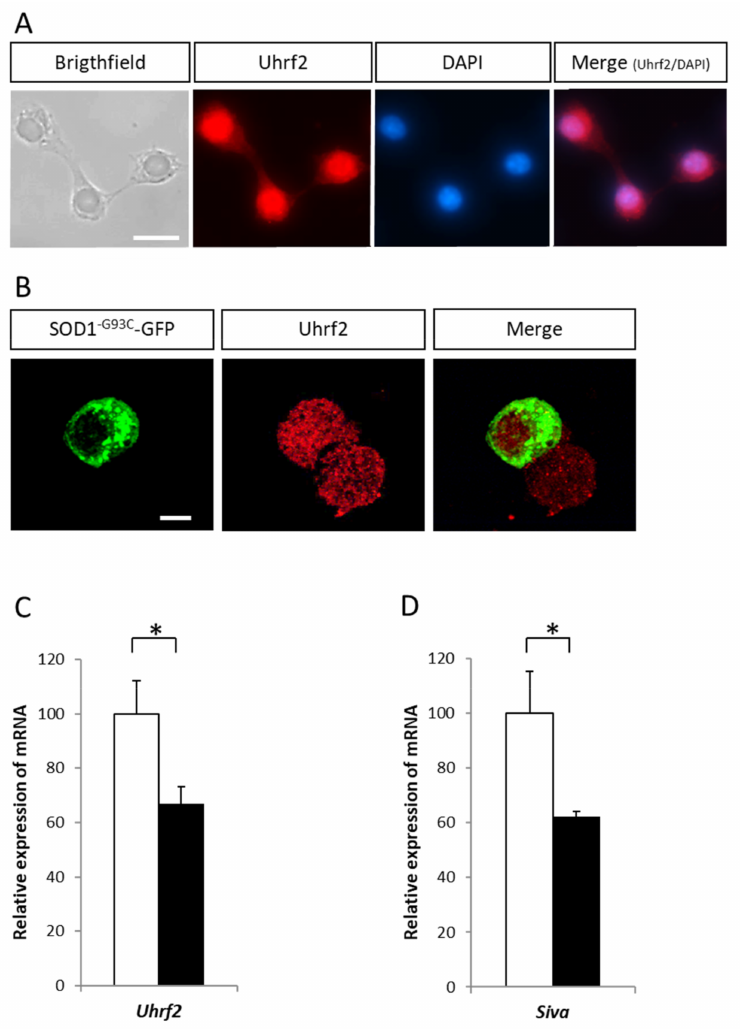
Figure 3. ( A ) Immunocytochemical visualization of Uhrf2 in NSC34 cells. ( B ) Absence of colo- calization of SOD1 G93C -GFP proteins with Uhrf2 in aggregates observed by confocal microscopy analysis. Scale bar: 10 µ m. ( C ) Relative mRNA expression of Uhrf2 (RT-qPCR analysis) in NSC-34 cells coexpressing SOD1 G93C -GFP and anti-Uhrf2 siRNA (or control siRNA) in presence of 1 mM of H 2 O 2 for 3 h. ( D ) Relative mRNA expression of Siva in NSC-34 cells coexpressing SOD1 G93C -GFP and siRNA anti-Uhrf2 (or siRNA control) in presence of 1 mM of H 2 O 2 for 3 h ( n = 3). * p <